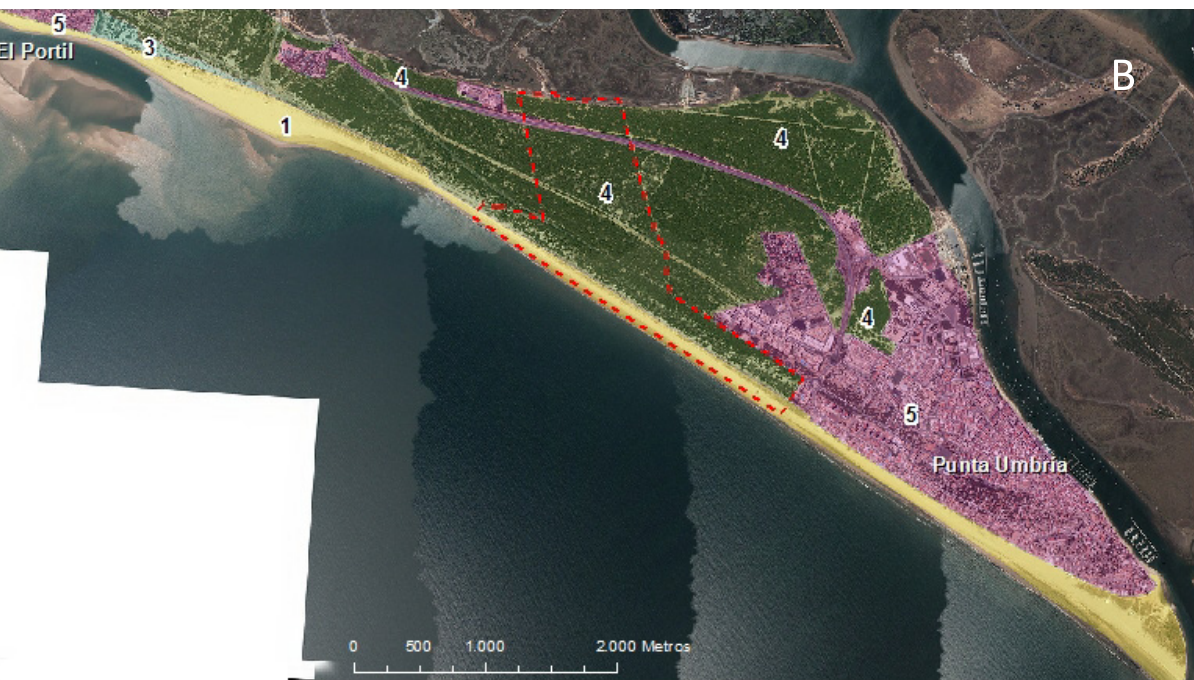
Figure 2. Vegetation map of Punta Umbria (Huelva) 1956 (A) and 2013 (B). The discontinuous red lines indicate the protected natural space. 1, Beach and the halo-nitrophilous communities; 2, Mobile dunes; 3, Semi-fixed dunes; 4, Stable dunes; 5, Table 3. Variation of plant communities surface (ha). Punta Umbria (Huelva) 1956 2013